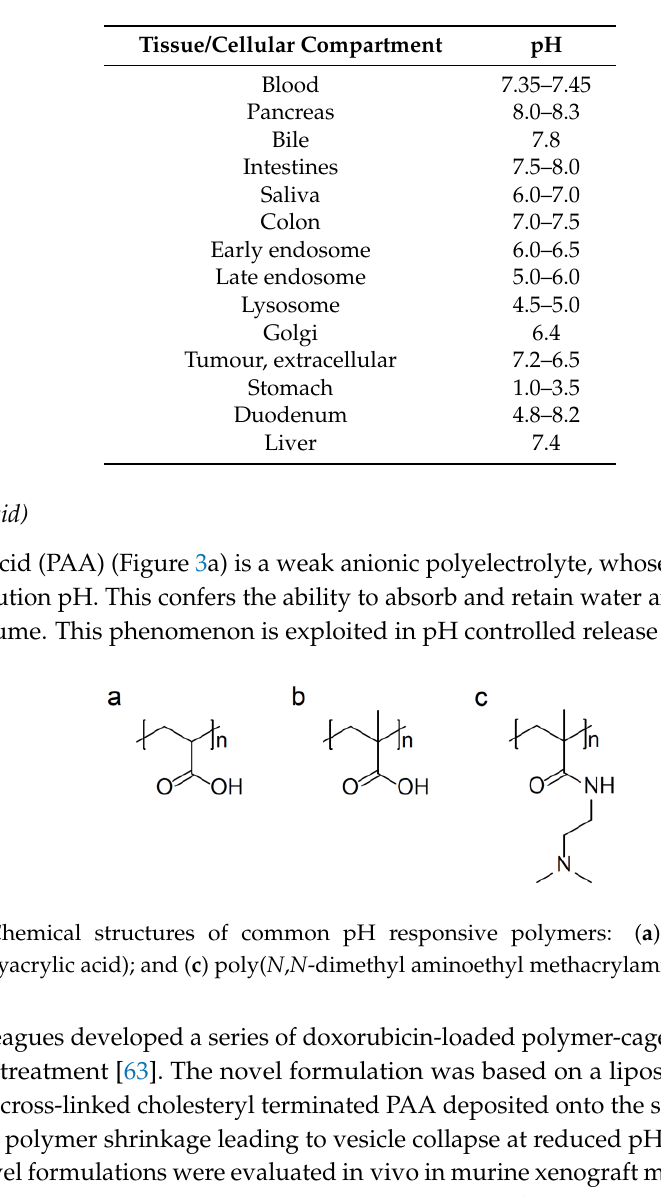
Table 2. Table showing the localised pH in different tissues and cell compartments [59–62].